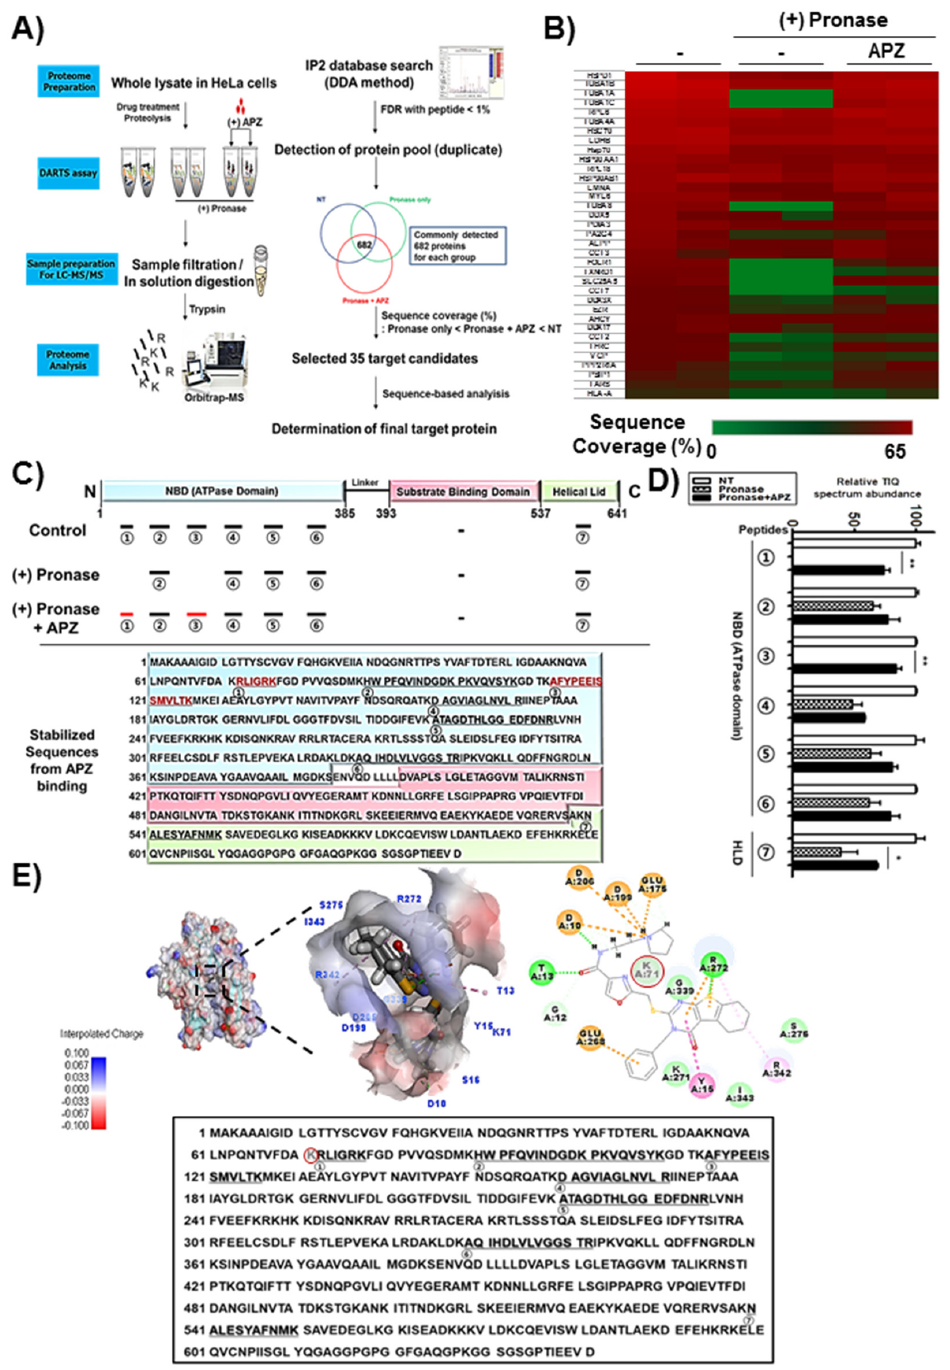
Figure 4. Combined drug a ffi nity responsive target stability (DARTS) and LC − MS / MS method identified a new protein target of APZ. ( A ) Schematic diagram of the DARTS and LC–MS / MS method. A label-free DARTS and LC–MS / MS method was applied to identify the protein target of APZ. First, a DARTS assay with pronase digestion was applied for three groups: (1) Control, (2) pronase-alone treated, (3) pronase treated with APZ in duplicate. Second, LC–MS / MS analysis of the proteome protected by the small molecule followed by protein searching based on peptides using the IP2 database were conducted. Finally, 35 protein target candidates were selected with reasonable sequence coverage values (pronase alone < pronase treated with APZ < control). Filtering based on function by known phenotype narrowed down functional targets. Rescue of sequence coverage in specific domain suggests binding specificity and a possible binding site. Certain domains were